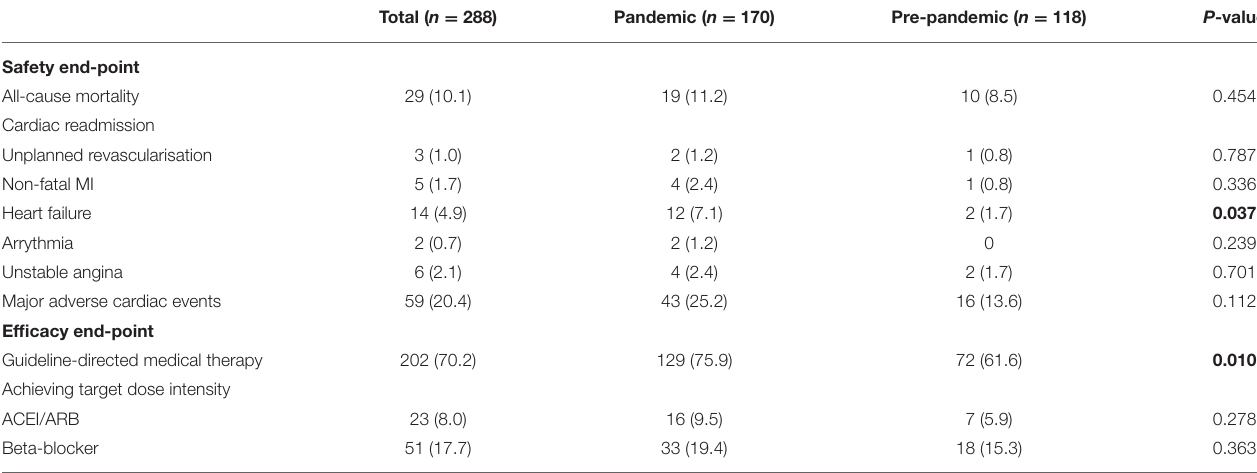
TABLE 3 | Safety and efficacy end-points of the study population during 1-year follow-up post-index ST-segment elevation myocardial infarction admission. Total ( n =